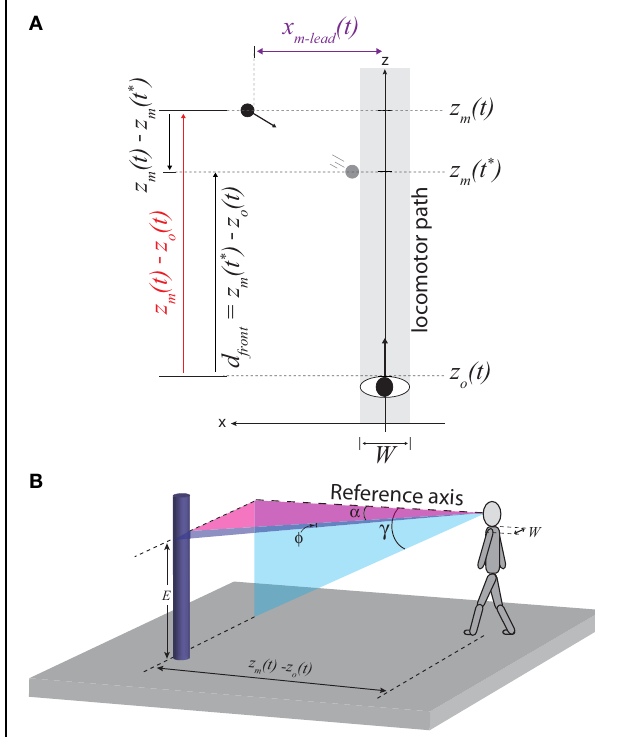
FIGURE 2 | (A) Top-down view of observer (body width, W ) moving straight ahead and an object (black circle) moving from left to right. z and x correspond to the positions of the observer (subscript o) and moving object (subscript m ), respectively. t corresponds to the current time and t* corresponds to the time at which the leading edge of the obstacle reaches the left side of the locomotor path. (B) Illustration of optical angles used in Equations